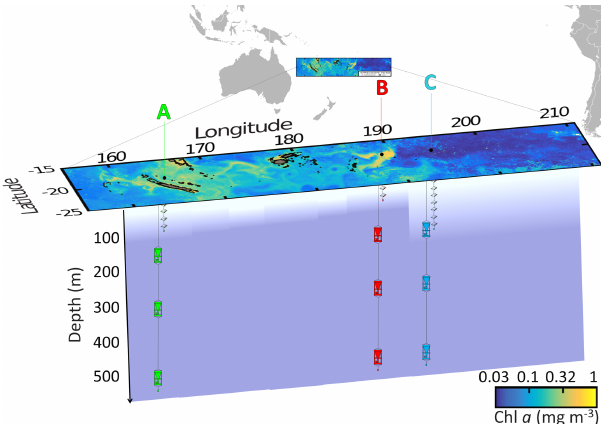
Figure 1. Position of the long-duration stations sampled in this study (OUTPACE cruise): LD A in green, LD B in red and LD C in blue on a quasi-Lagrangian surface Chl a concentrations map. The in situ production lines were deployed in the photic layer (from 5 to 105, 80 and 180m for LD A, LD B and LD C, respectively) and the PPS5 sediment traps were deployed at 150, 330 and